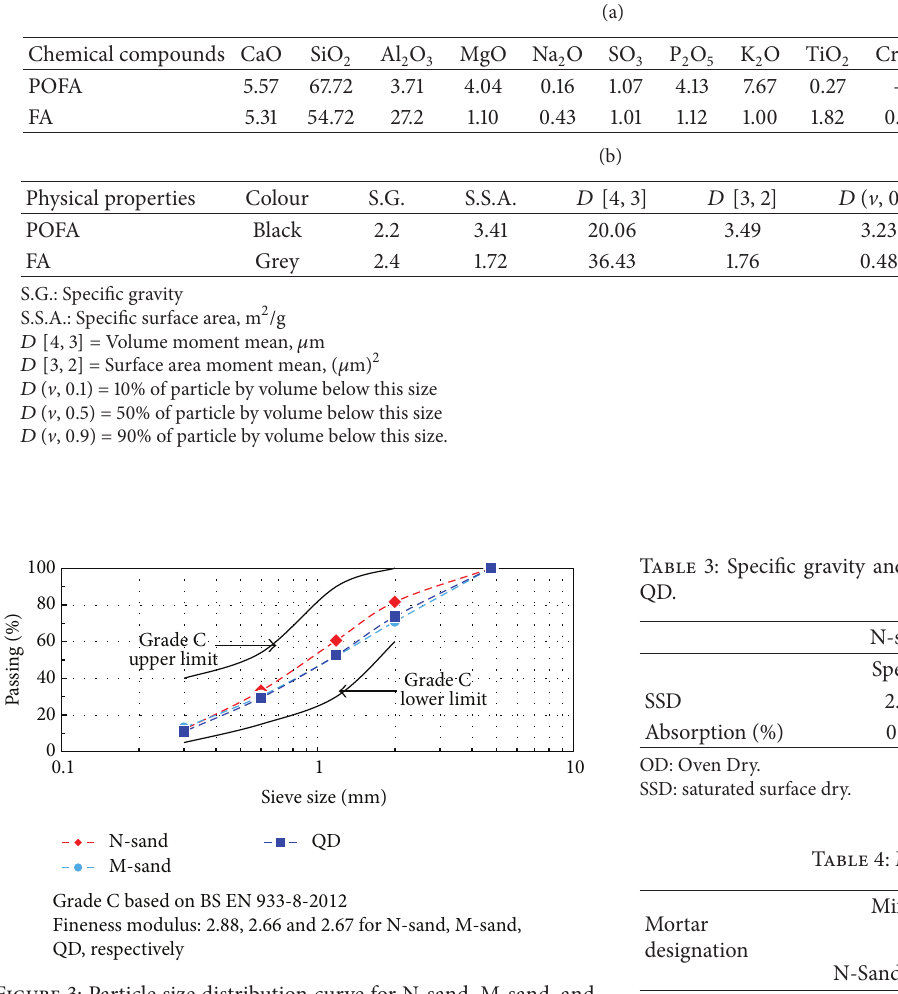
Figure 3: Particle size distribution curve for N-sand, M-sand, and QD.